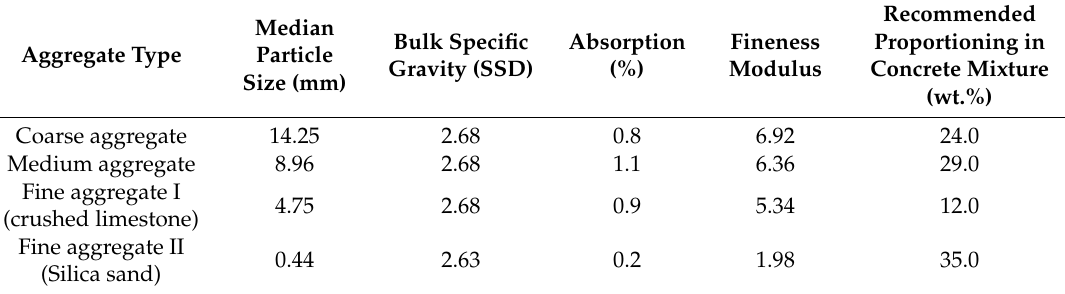
Table 2. The physical properties of the used aggregates.